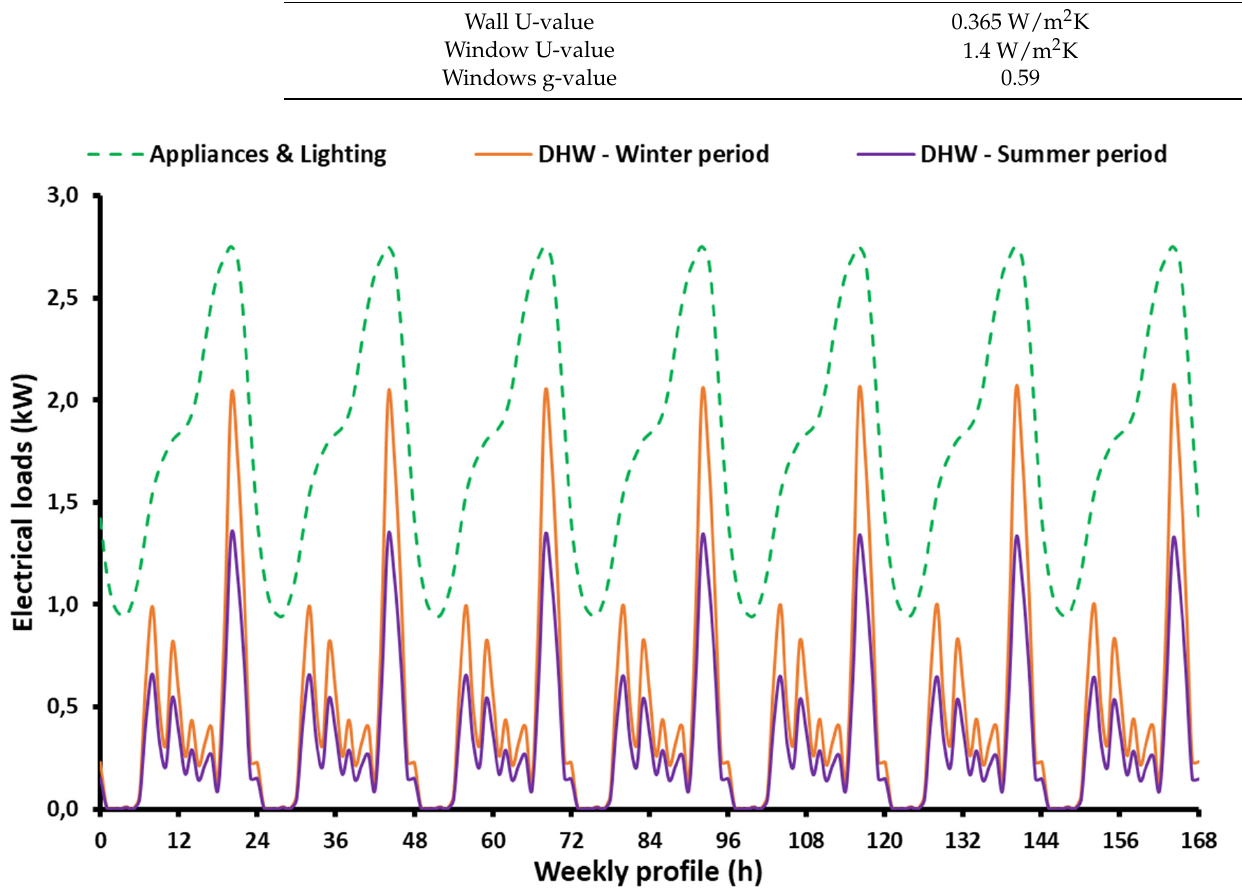
Figure 1. Description of the electrical profile demands for DHW, and appliances—lighting.